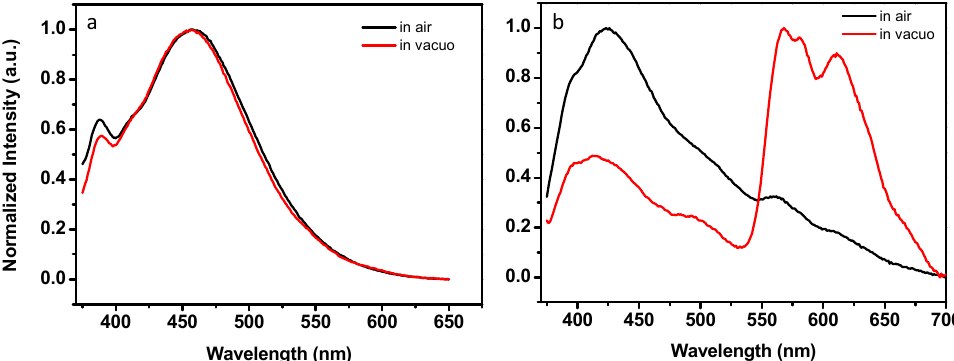
Figure 3. Steady-state emission spectra (298 k) of NI-PU3 ( a ) and NIBr-PU3 ( b ) in air (black line) and in vacuo (red line) ( λ ex = 365 nm).